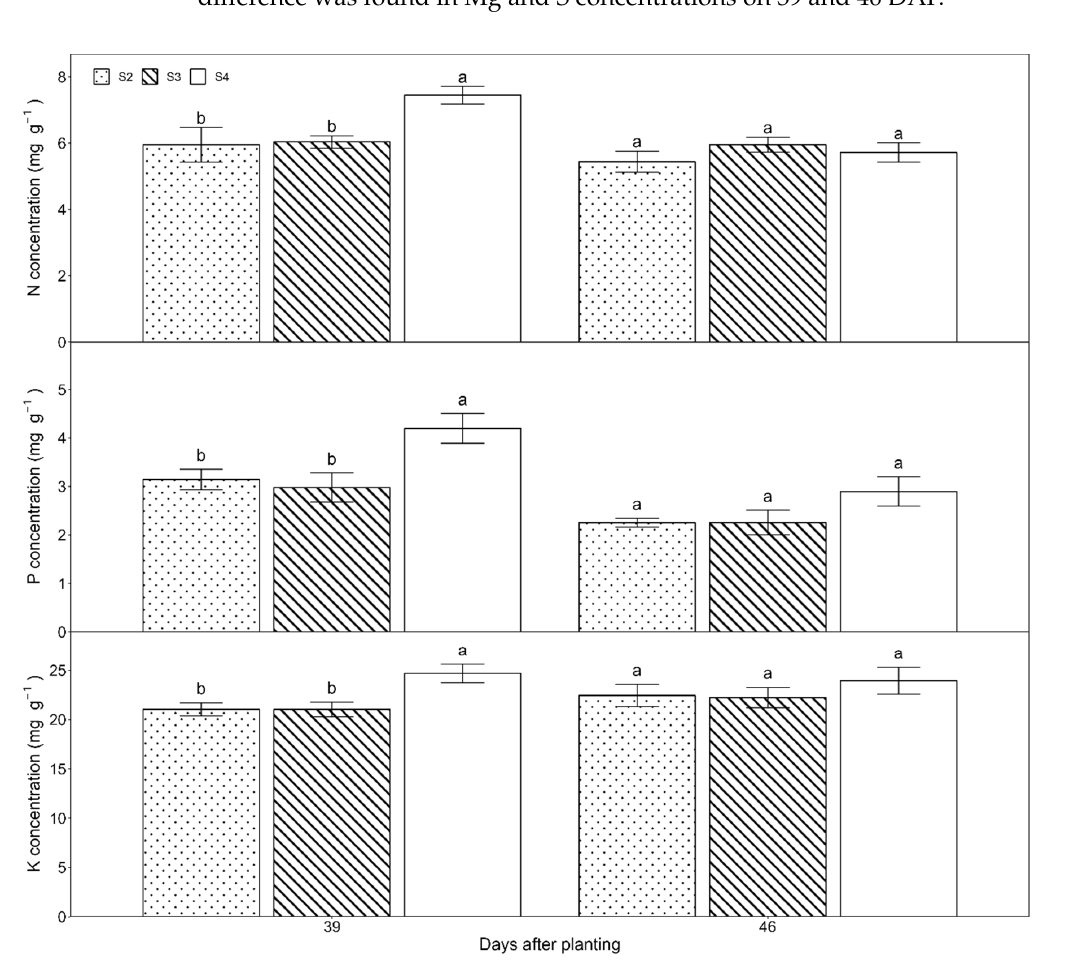
Figure 5 . The N, P and K concentrations in leaves on 39 and 46 DAP in EXP.2. Note: S2, S3 and S4 refer to two equal sections, three equal sections and four equal sections, respectively in EXP. 2. The different lower-case letters indicate significant probability difference at p < 0.05 among numbers of sectioning. The error bars represent standard errors ( n =